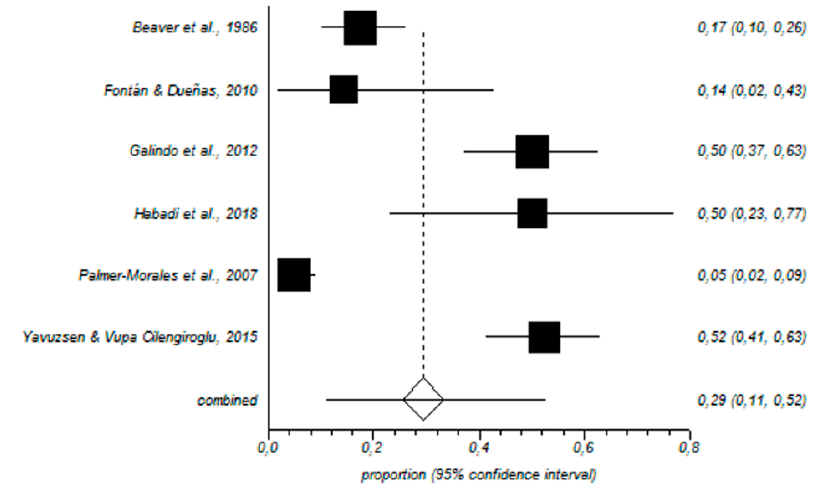
Figure 2. Forest plot for high emotional exhaustion.